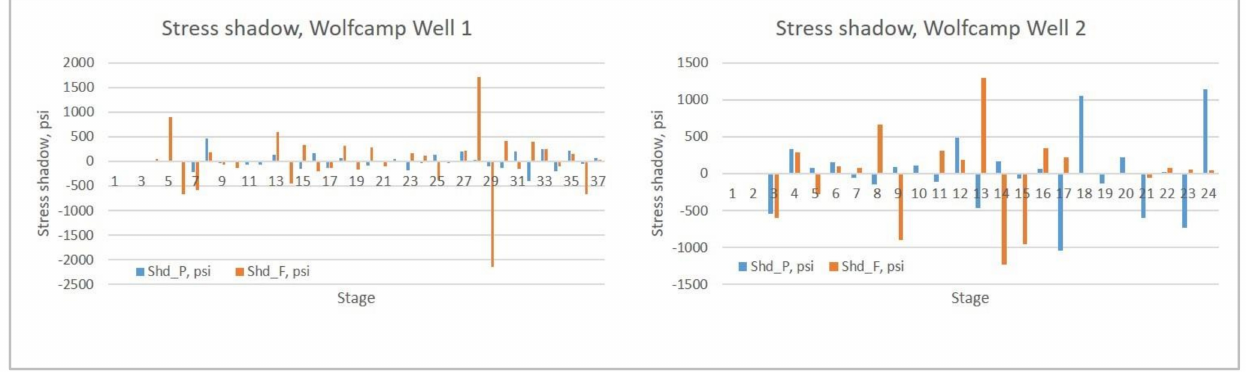
Figure 9. Stress shadows of two Wolfcamp